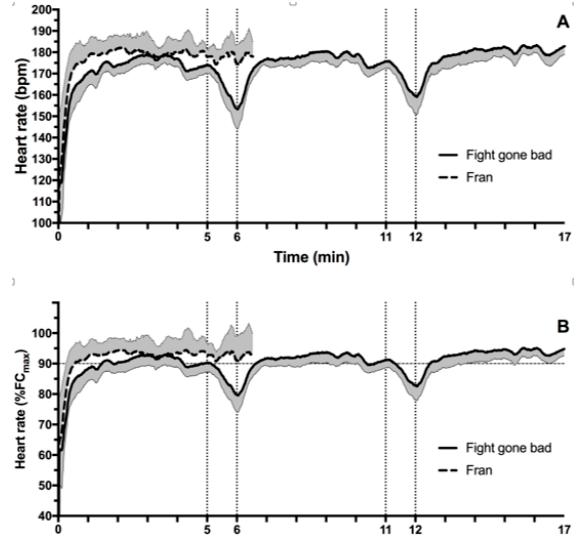
Figure 3. Heart rate (HR) during CrossFit ® sessions. ( A ) Absolute values; ( B ) relative values of HRmax using the 220-age equation. The shaded area corresponds to the standard deviation of HR during sessions.